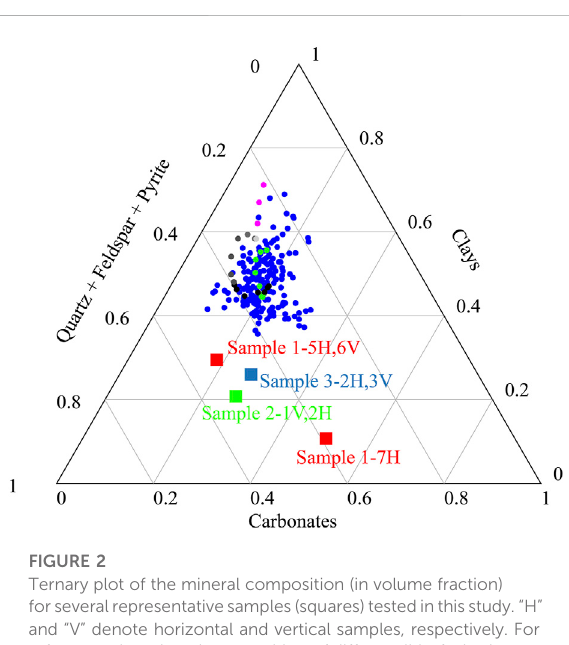
FIGURE 2 Ternary plot of the mineral composition (in volume fraction) forseveralrepresentativesamples(squares)testedinthisstudy. “ H ” and “ V ” denote horizontal and vertical samples, respectively. For reference, the mineral composition of different lithofacies in Well 1 is shown as dots with colors indicated by the stratigraphic column in Figure